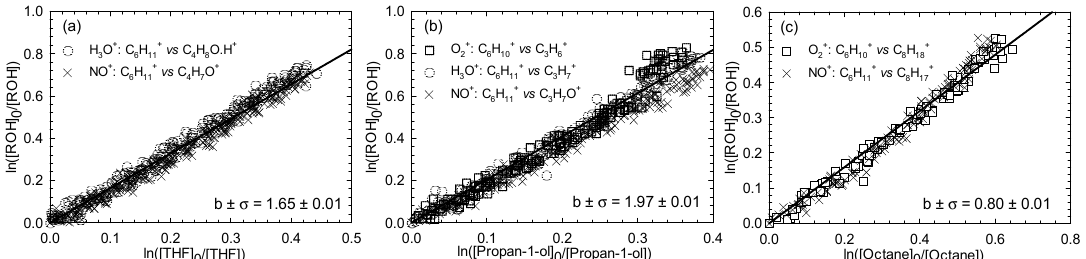
Figure 2. Relative loss of ( E )-2-hexen-1-ol vs. that of THF ( a ), propan-1-ol ( b ), and octane ( c ) in the Cl atom-initiated reaction.